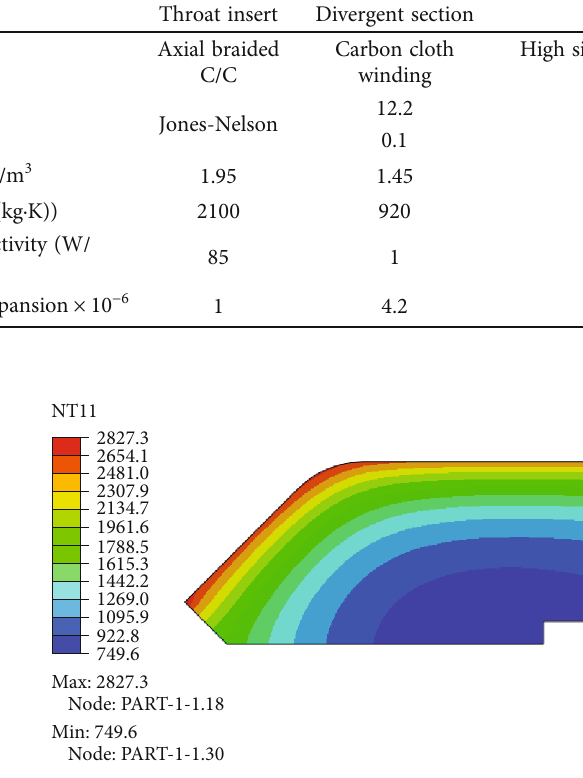
Figure 6: Temperature contour at 20s (the unit is k